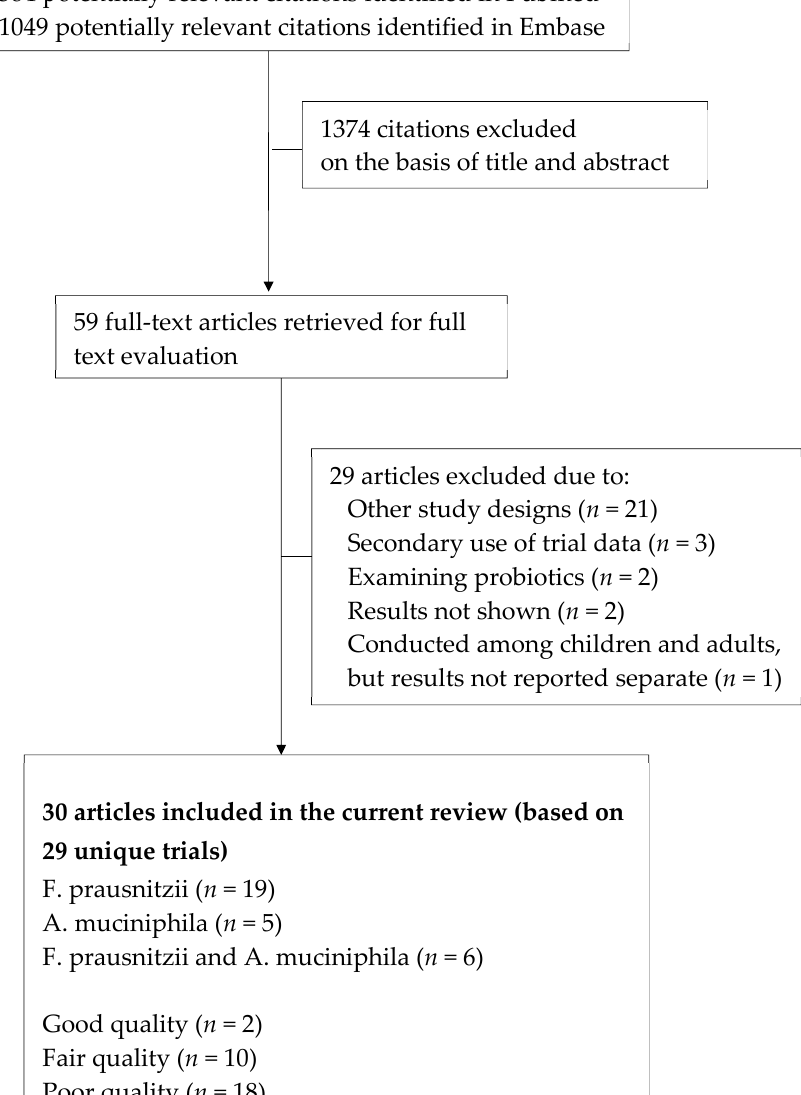
Figure 1. Flowchart of studies included in the current review.